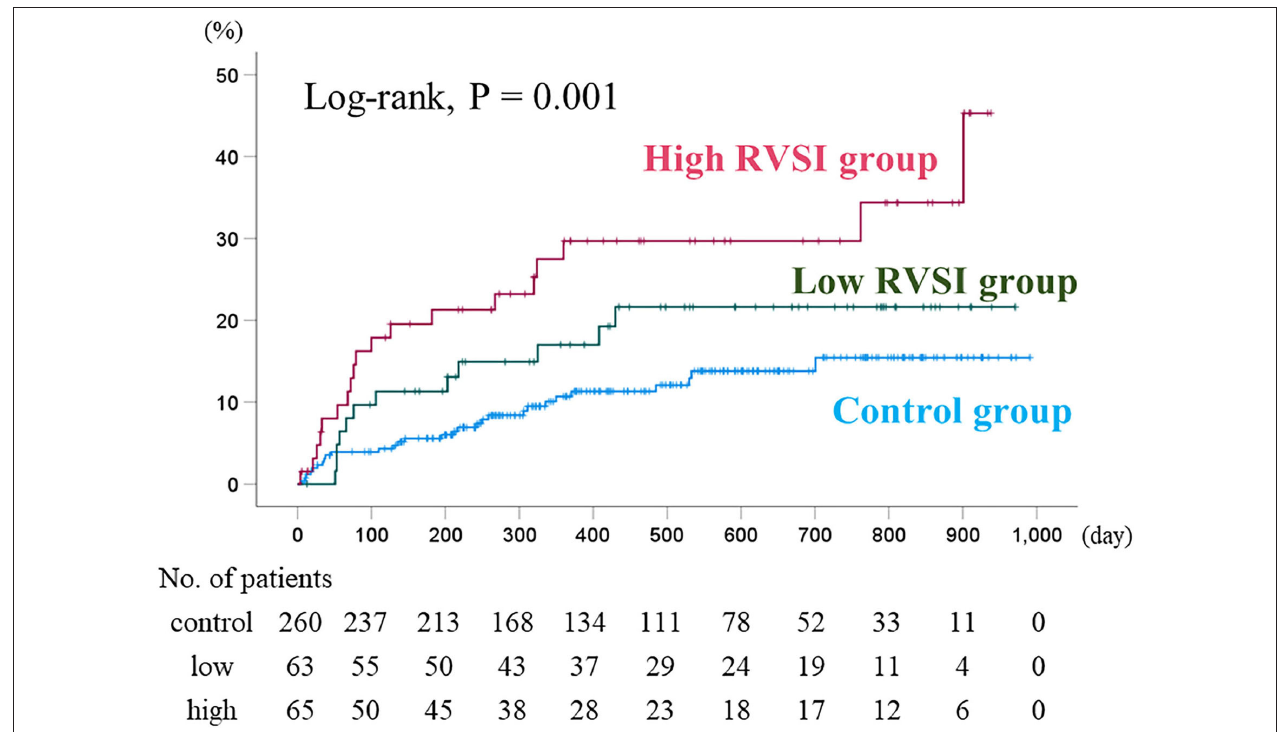
FIGURE 3 | Kaplan–Meier analysis for cardiac event rates stratified by RVSI. The cumulative cardiac event rate significantly increased with increasing RVSI (log-rank, P = 0.001). RVSI, renal venous stasis index.